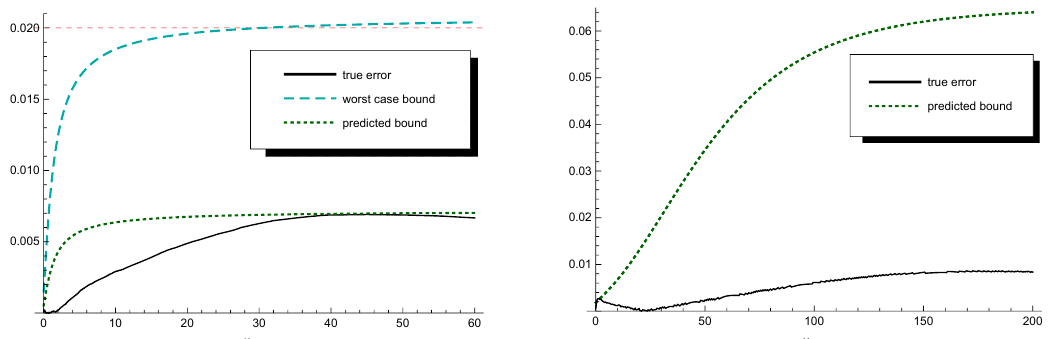
Figure 3. Comparison between the error bound and the true error, under Pareto ( 2,3 ) ( left graph ) and Weibull ( 0.5,3 ) ( right graph ) claim sizes. The dashed cyan line in the left graph corresponds to the worst-case scenario for the bound that was used to determine the number of phases in the spectral approximation that guarantee δ = 0.02 up to u = 30.